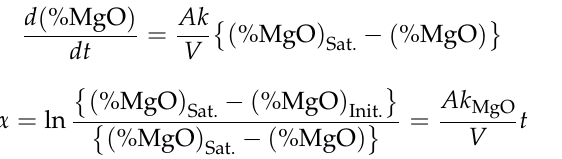
Table 2. Initial compositions of the slag and matte reported by [8].